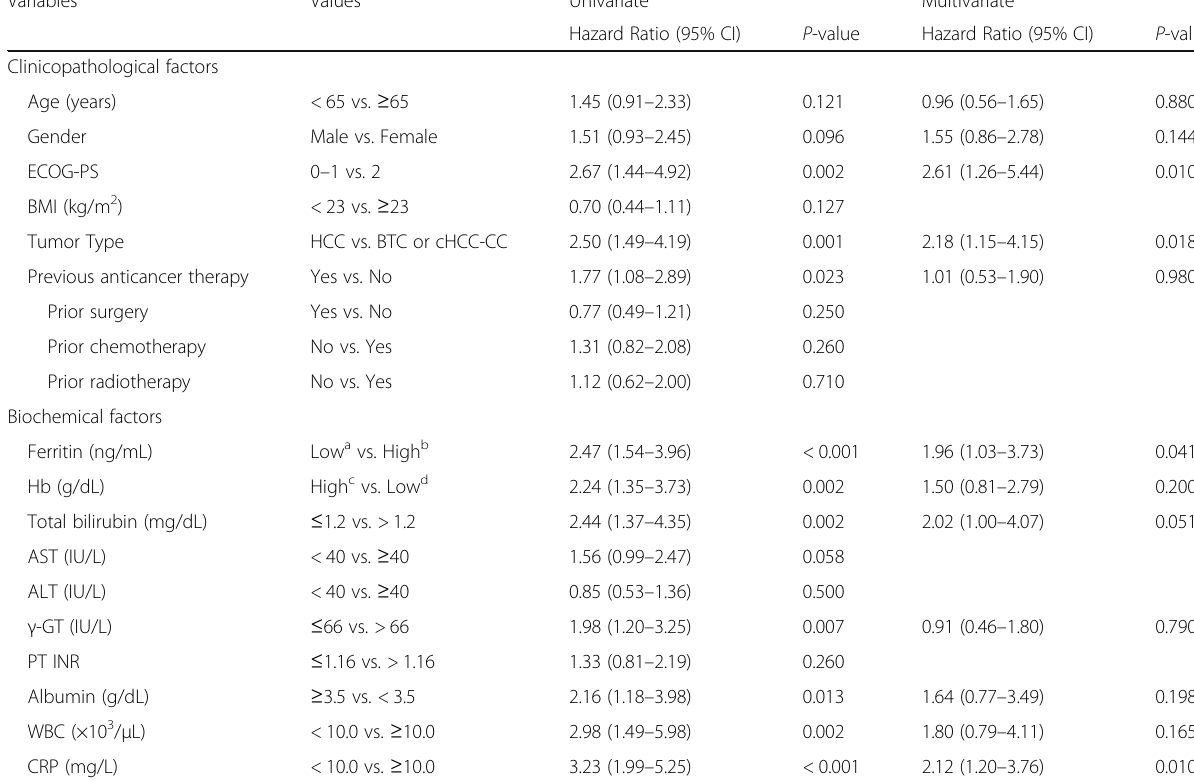
Table 3 Univariate and multivariate analysis of factors affecting overall survival of patients with advanced hepatobiliary cancers ( n = 80) Variables